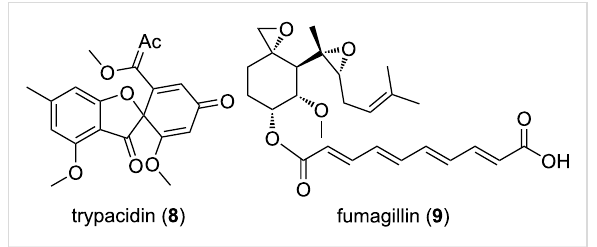
Figure 4: Amoebicidal secondary metabolites trypacidin and fumag- illin of Aspergillus fumigatus .